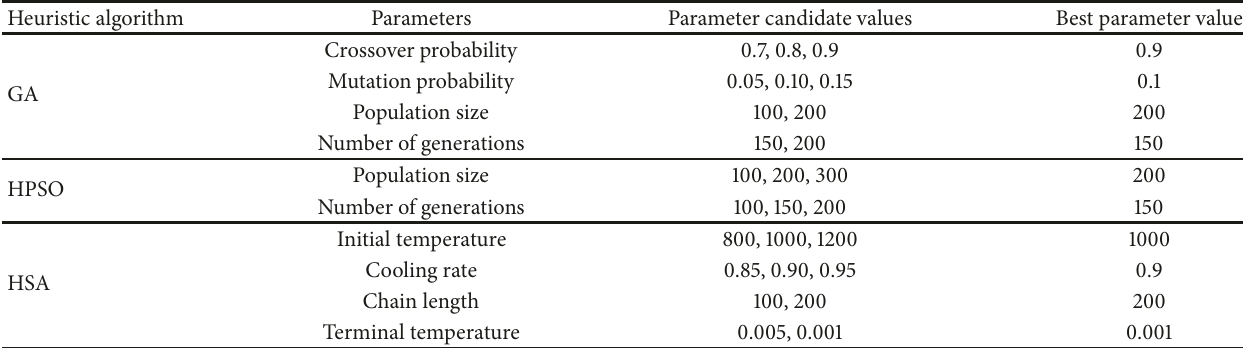
Table 2: Parameter selection for heuristic algorithms.